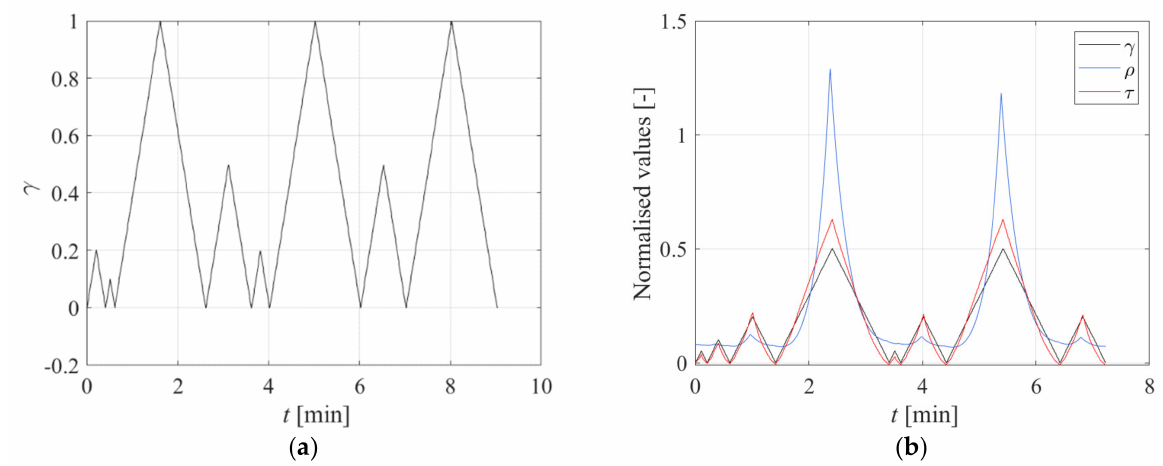
Figure 19. ( a ) History of input, ( b ) History of normalised input, stress, and resistivity.